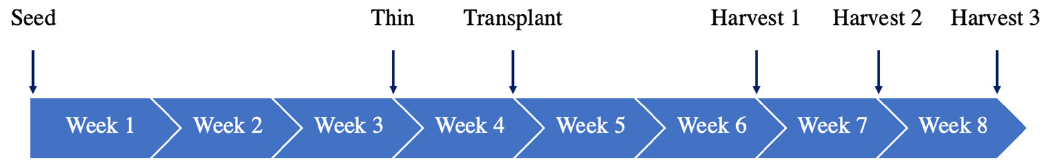
Figure 3. Timeline for each of the three crop cycles in the experiment .